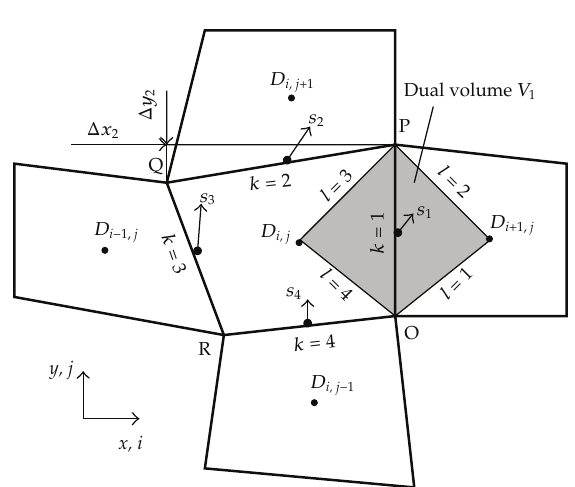
Figure 2: Finite volume D i,j and dual volume V (cid:3)